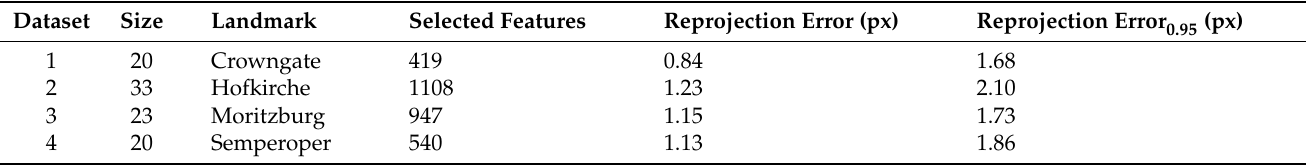
Table 2. Determined features, reprojection error, and 95% quantile of the reprojection error of the benchmark datasets.